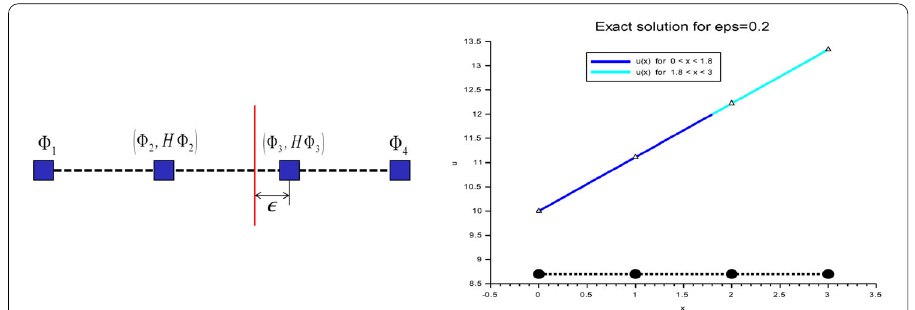
Fig. 8 1D case with X-FEM interface and linear elements. Left, the three elements used in the model. Right, the analytical solution expected. The use of a discontinuous function is possible because discontinuous degrees of freedom bear Neumann conditions that enforce the continuity of the solution (as in a contact problem with Lagrange multipliers at the